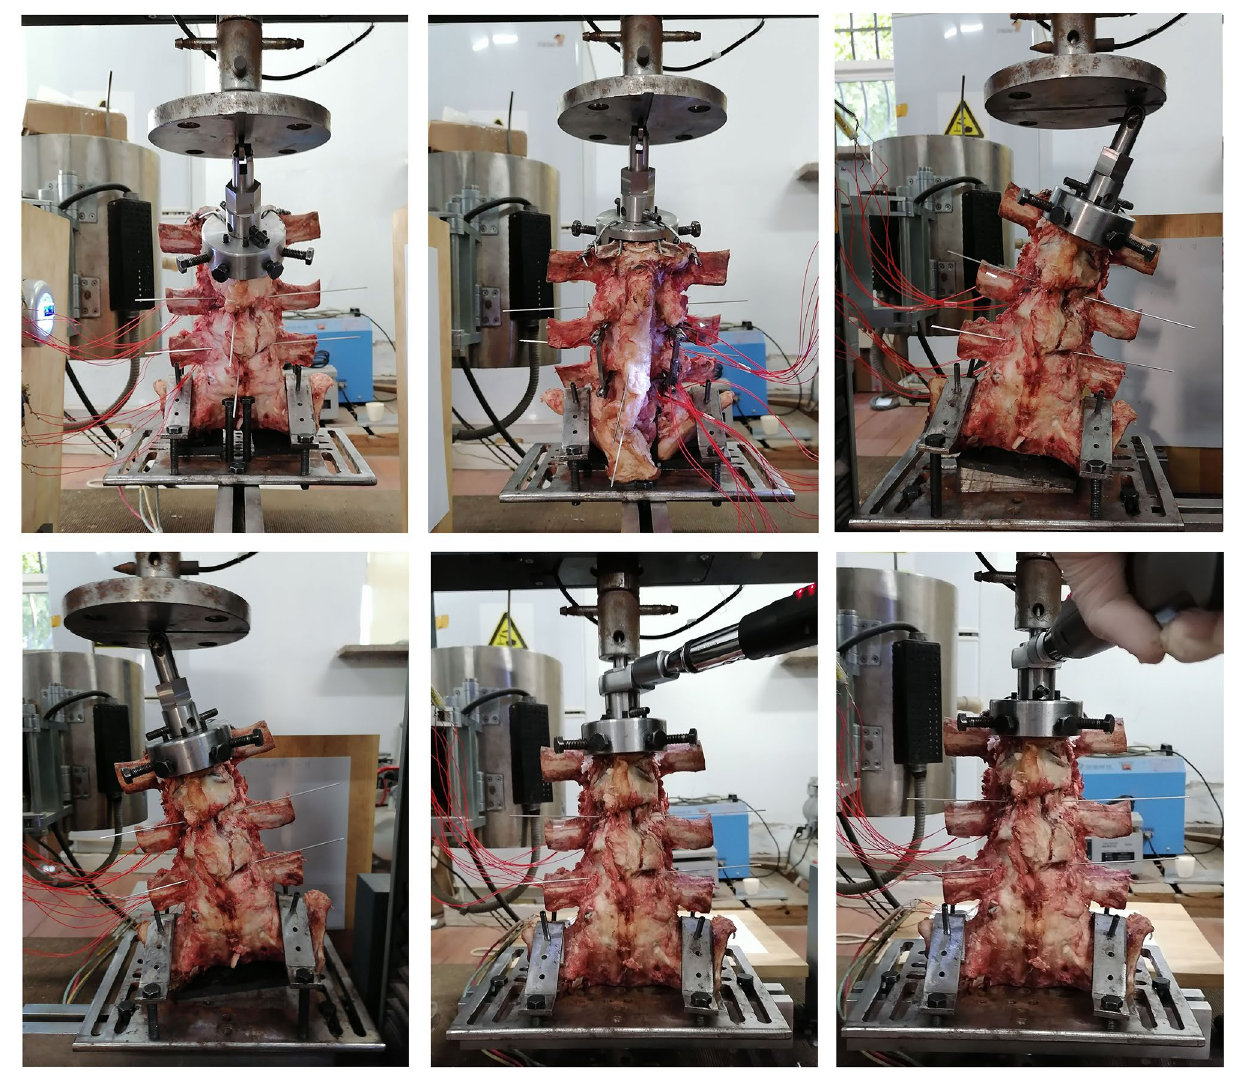
Figure 13. Simulation of six different working conditions on the test